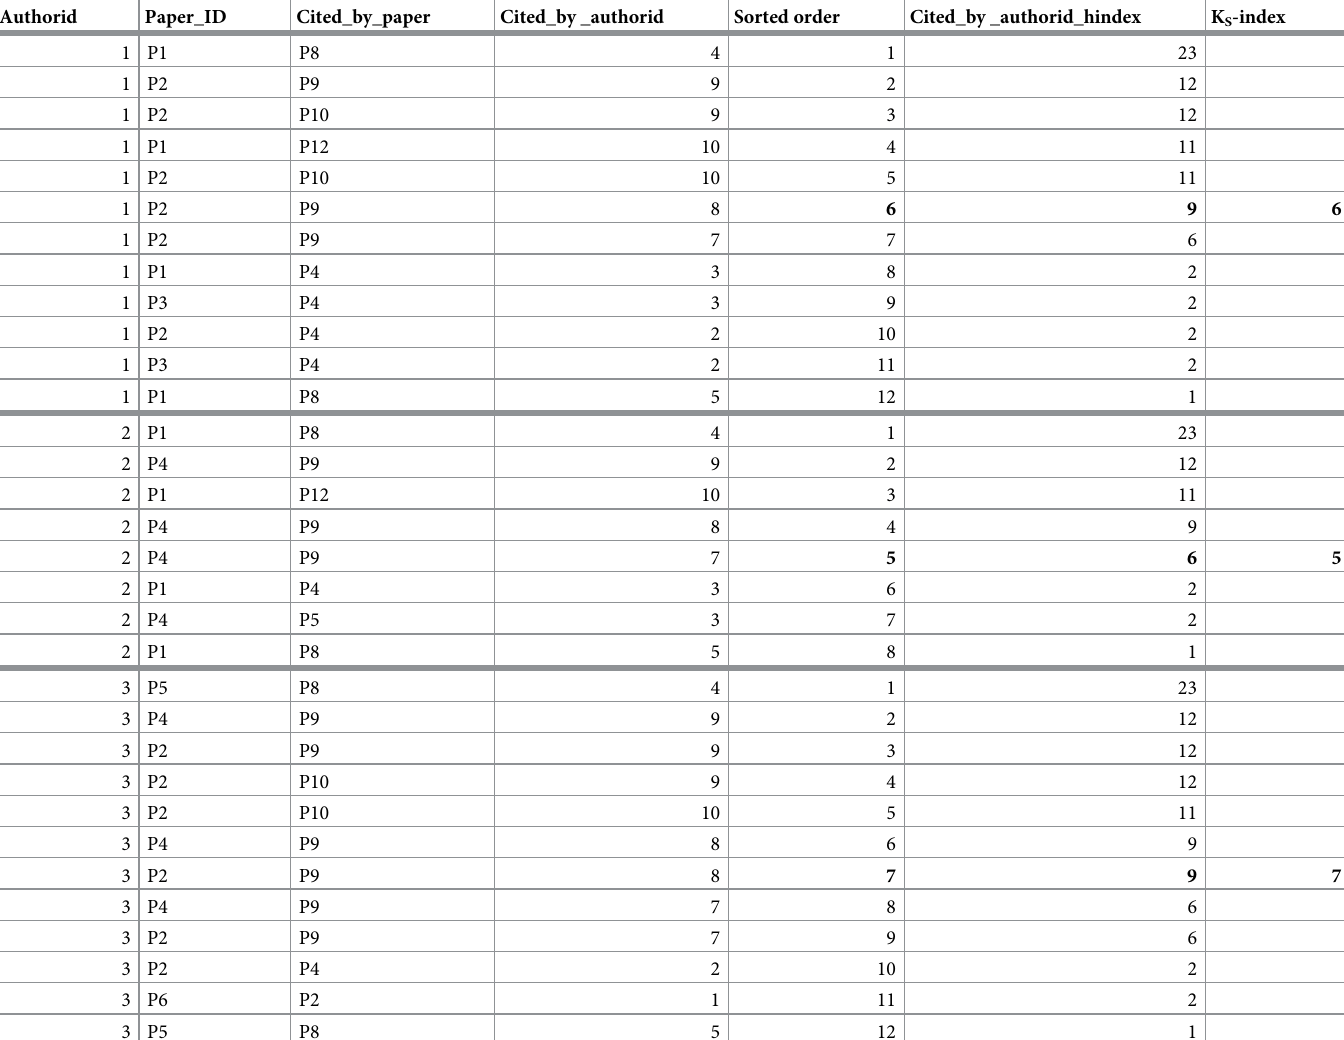
Table 9. Calculation of K S